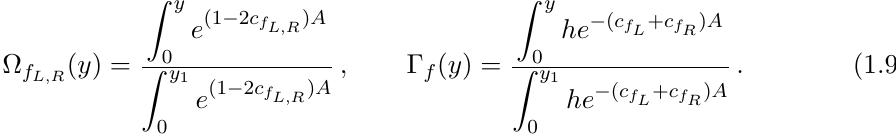
Figure 3 . Contribution to the electron (dashed red line), muon (solid black line), tau lepton (dot-dashed green line) and bottom quark (dotted blue line). The allowed region corresponds to the regime have considered ( c e